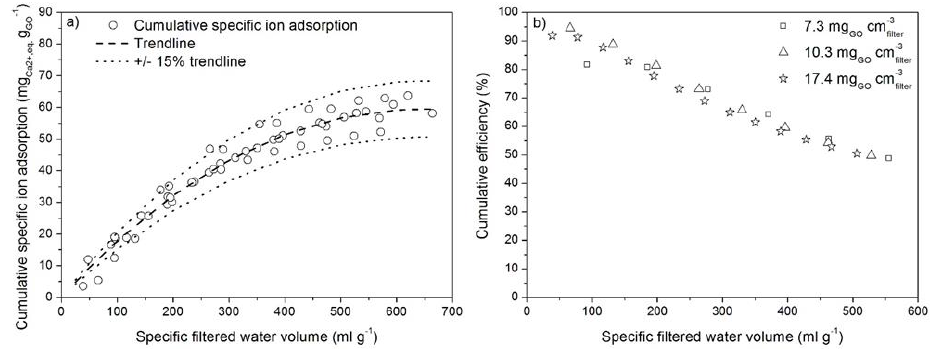
Figure 4. Specific cumulative divalent ions adsorption ( a ) and cumulative efficiency ( b ) as a function of specific filtered water volume for GO inventories of 7.3, 10.3, and 17.4 mg GO per unit volume of foam filter.